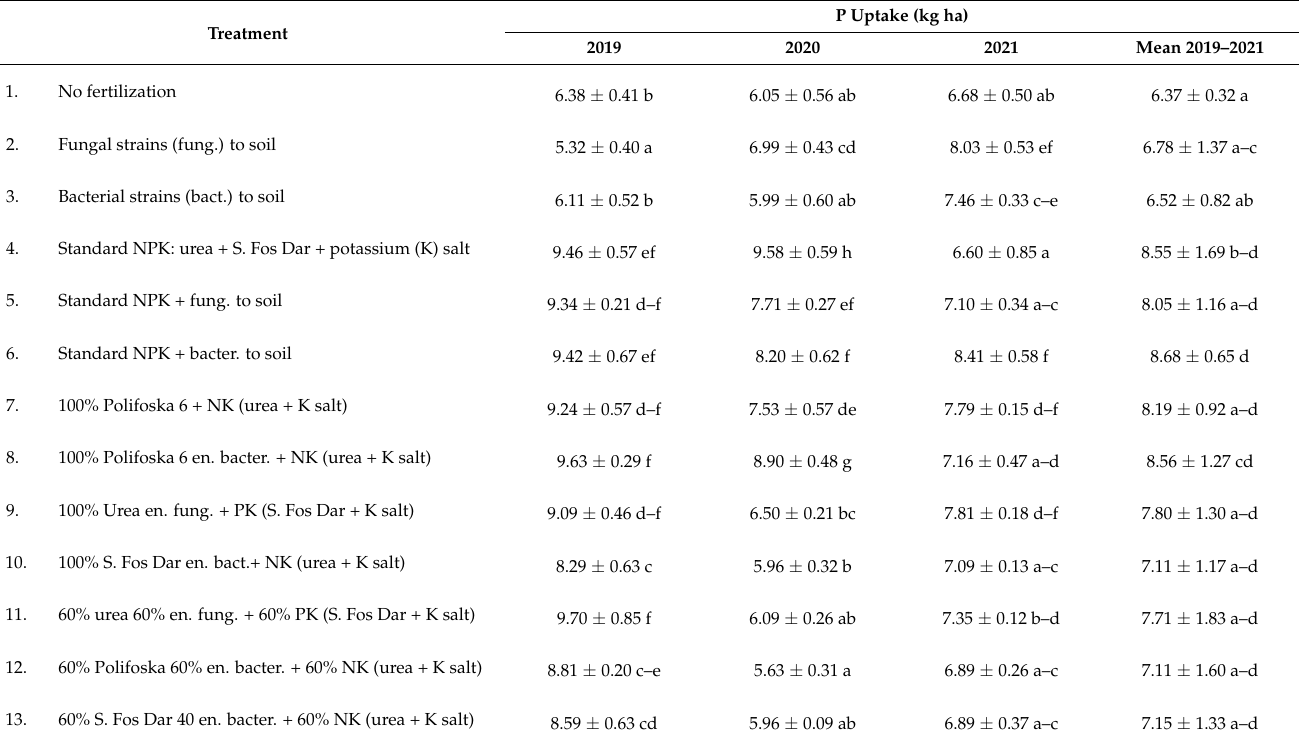
Table 7. P uptake by weed shoots in the apple orchard, 2019–2021. Treatment